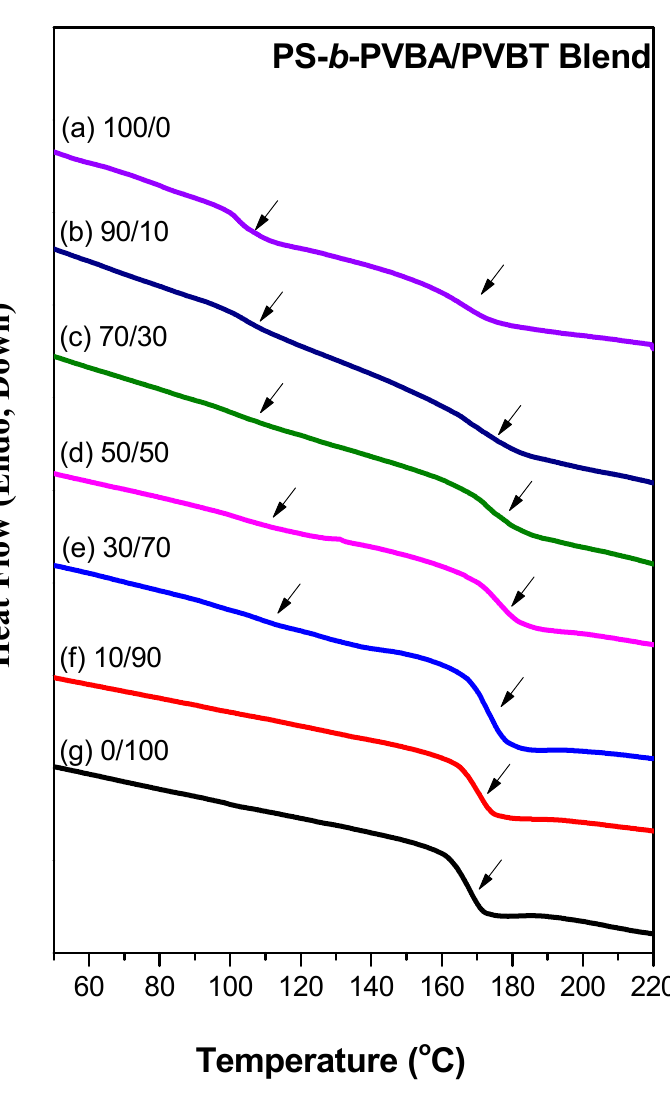
Figure 4. DSC thermograms of PS- b -PVBA/PVBT diblock copolymer/homopolymer blends of various compositions.